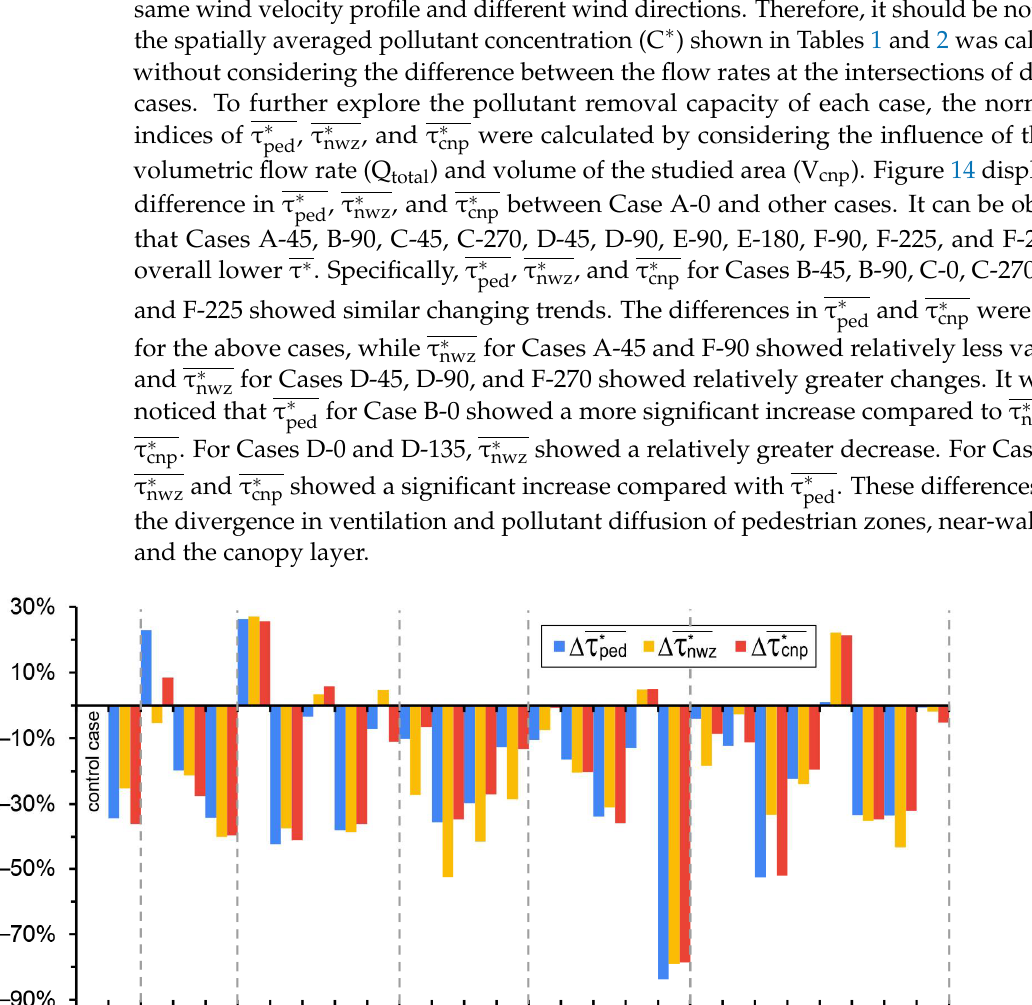
Figure 14. Difference of spatially average normalized age of air ( ∗ (cid:3365) ) for all cases, taking Case A-0 as the control case.